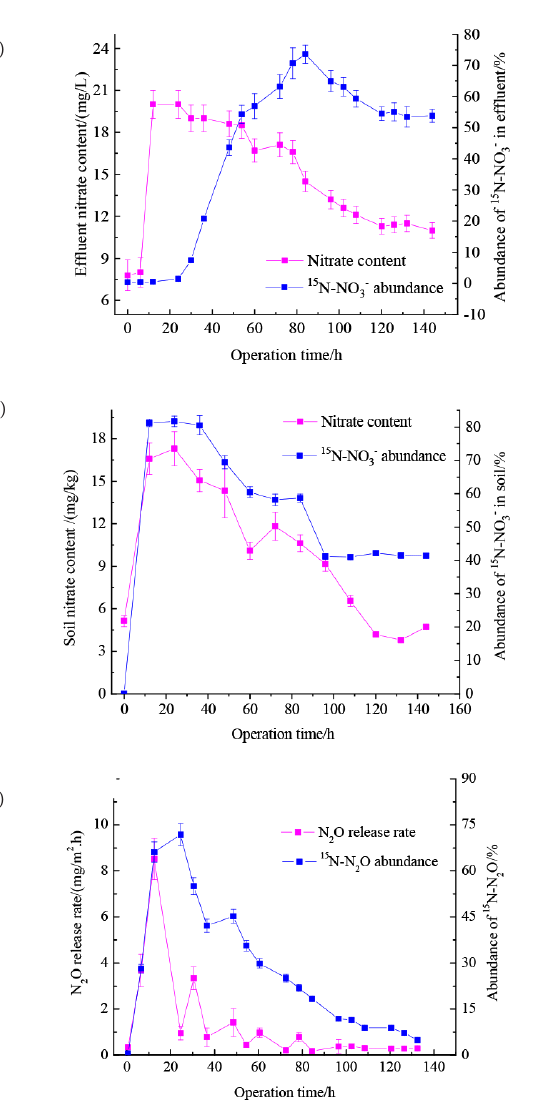
Figure 2. (a) Nitrate concentration and 15 N-NO 3– abundance in effluent, (b) Nitrate concentration and 15 N-NO 3 – abundance in soil and (c) N 2 O release rate and 15 N-N 2 O